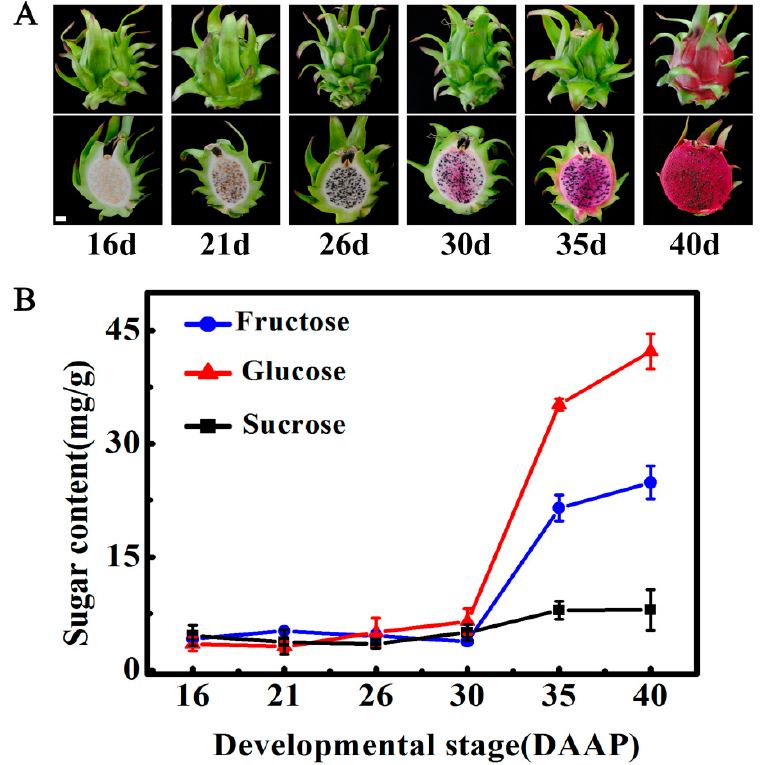
Figure 1. Glucose is the main sugar in mature pitaya fruit. ( A ) Photograph of pitaya fruit at different developmental stages. ( B ) Changes of soluble sugars (glucose, fructose, and sucrose) contents during fruit maturation. Fruit at 16, 21, 26, 30, 35, and 40 days after artificial pollination (DAAP) was sampled for analysis. Data represent mean values from three biological replicates (± S.E.).